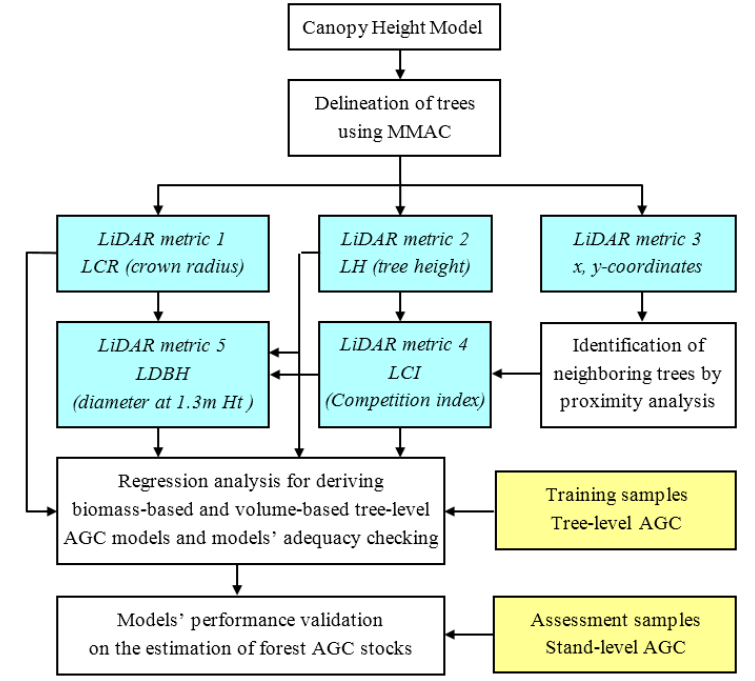
Figure 2. Flowchart of the above-ground-biomass carbon accounting process.